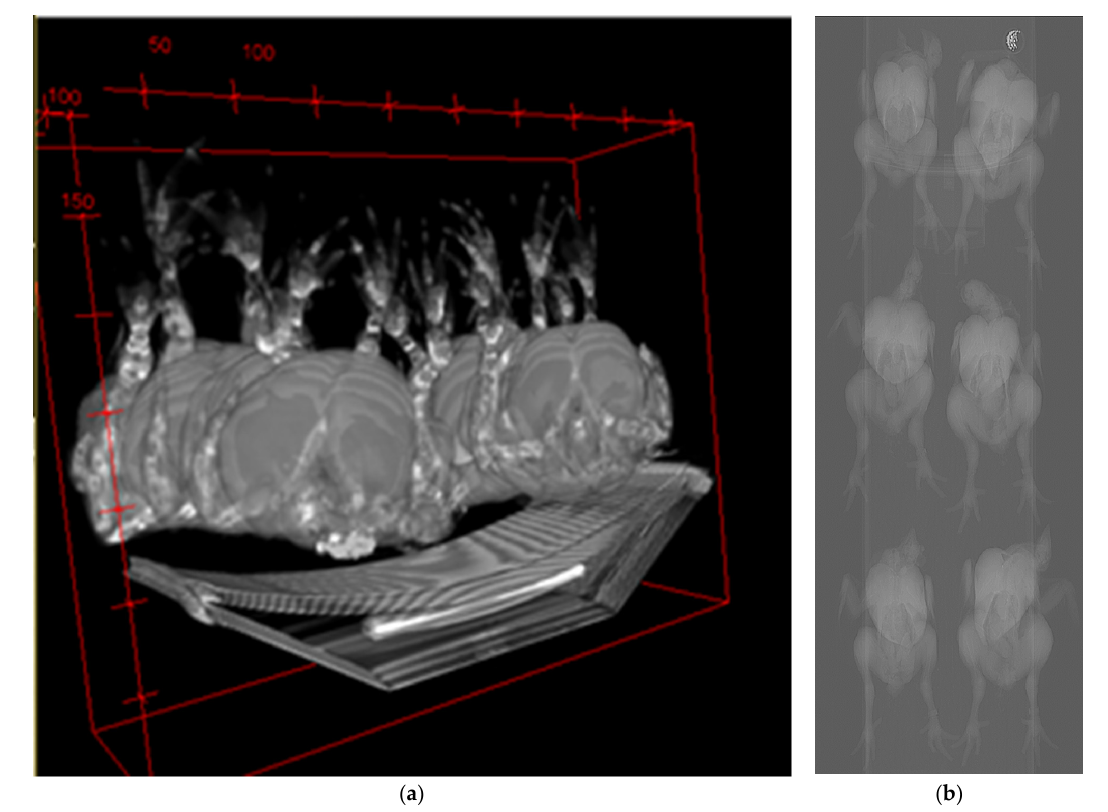
Figure 1. Computed tomography (CT) image of broiler carcasses for tissue composition determination: ( a ) three-dimensional view from the craniocaudal aspect and ( b ) dorsoventral view of six broiler carcasses arranged on the CT scanner bed. Immediately after scanning the broiler carcasses, breast muscles (pectoralis major and minor), drumsticks (muscle), and thighs (muscle) were removed from the carcasses and individually weighed to determine cut yield. Thigh, drumstick, and breast meat yields were expressed as a percentage of the live body weight as described previously [27–29]. The live body weight is described and published as individual body weight in de Souza et al. [5]. The paired breast muscles were labeled (treatment group, right and left side), placed pairwise in plastic bags, and stored overnight at 4 ◦ C. On the following morning (approximately 24 h post-mortem), individual breast muscles were consistently partitioned for meat quality measurements (Figure 2).